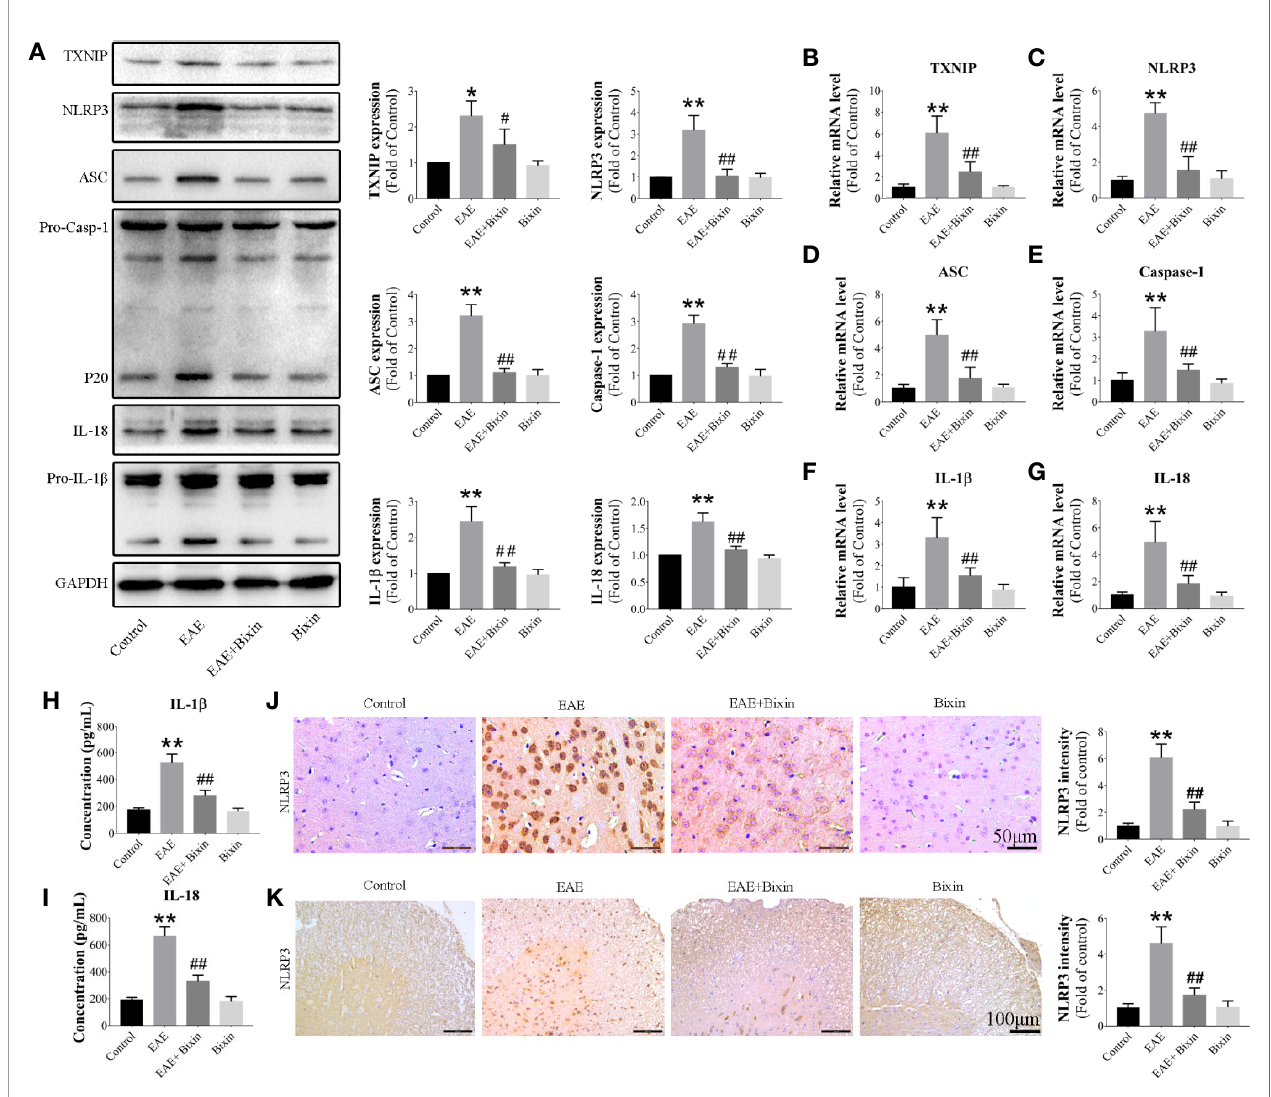
FIGURE 4 | Bixin suppresses the activation of the TXNIP/NLRP3 in fl ammasome in EAE mice (A) . The protein levels of TXNIP/NLRP3 in fl ammasome components were assessed by western blotting (B – G) . mRNA expression of TXNIP/NLRP3 in fl ammasome components were quantitated by qRT-PCR (H, I) . IL-1 b and IL-18 levels in serum were measured by ELISA. Representative IHC images of NLRP3 in brain sections (J) (Scale bars: 50 m m) and spinal cord sections (K) (Scale bars: 100 m m), and the quantitative results are shown. Data shown in graphs represents the means ± SD (n = 5). *P < 0.05, **P < 0.01, vs. control group; # P < 0.05, ## P < 0.01, vs. EAE